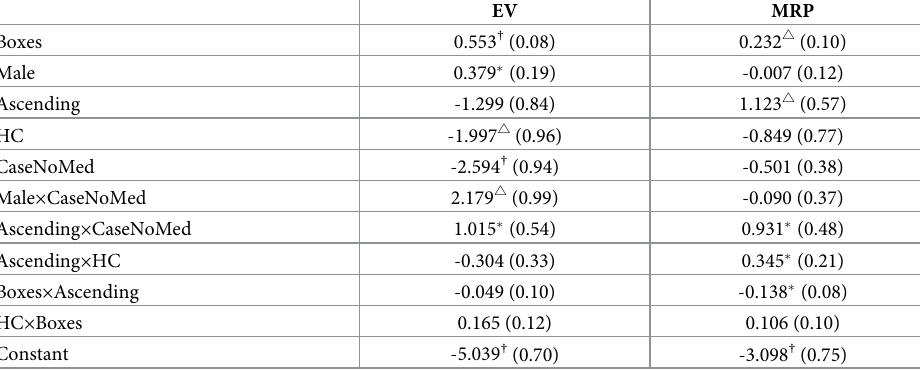
Table 4. Multinomial regression model for the probabilities of agreement with EV and MRP. Estimated parameters (standard errors in parentheses). Baseline outcome is no agreement with either model. Boxes is the number of boxes, among the 10 boxes shown on the screen, with the highest probability color; HC is equal to one for healthy controls and CaseNoMed is equal to one for non medicated OCD patients, so that the reference group is that of